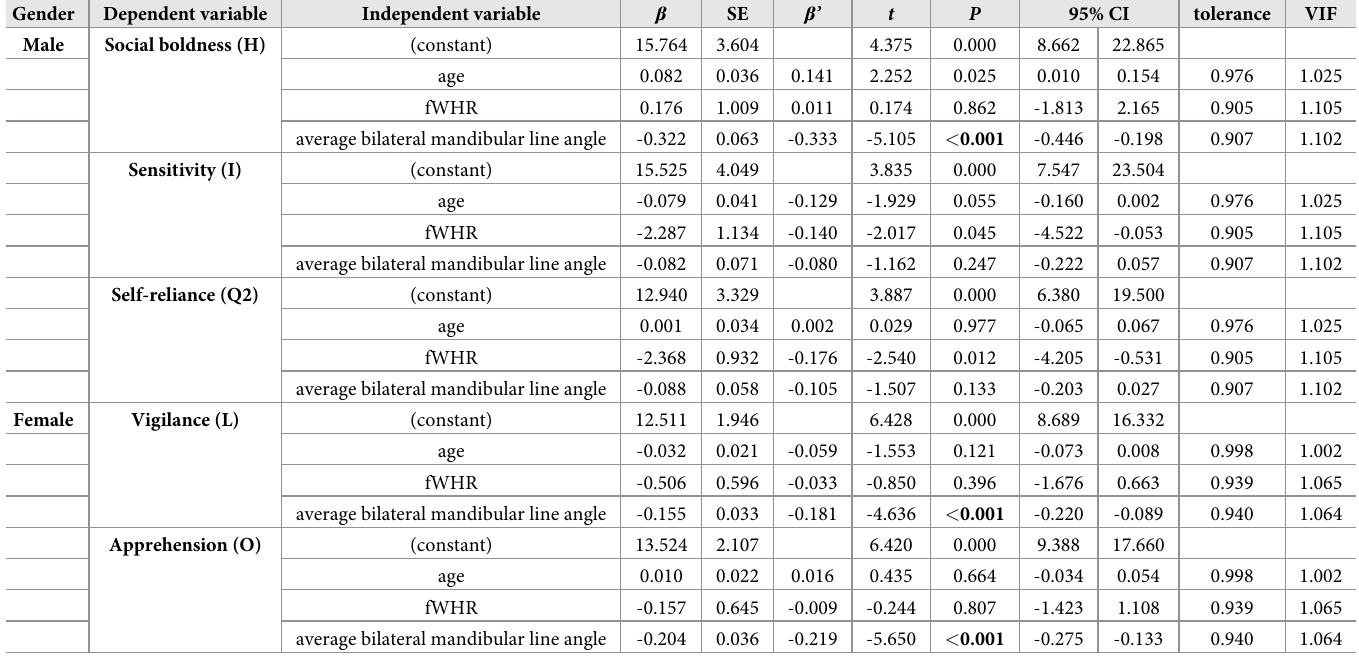
Table 4. Regression analysis of influence of facial feature indicators on 16PF